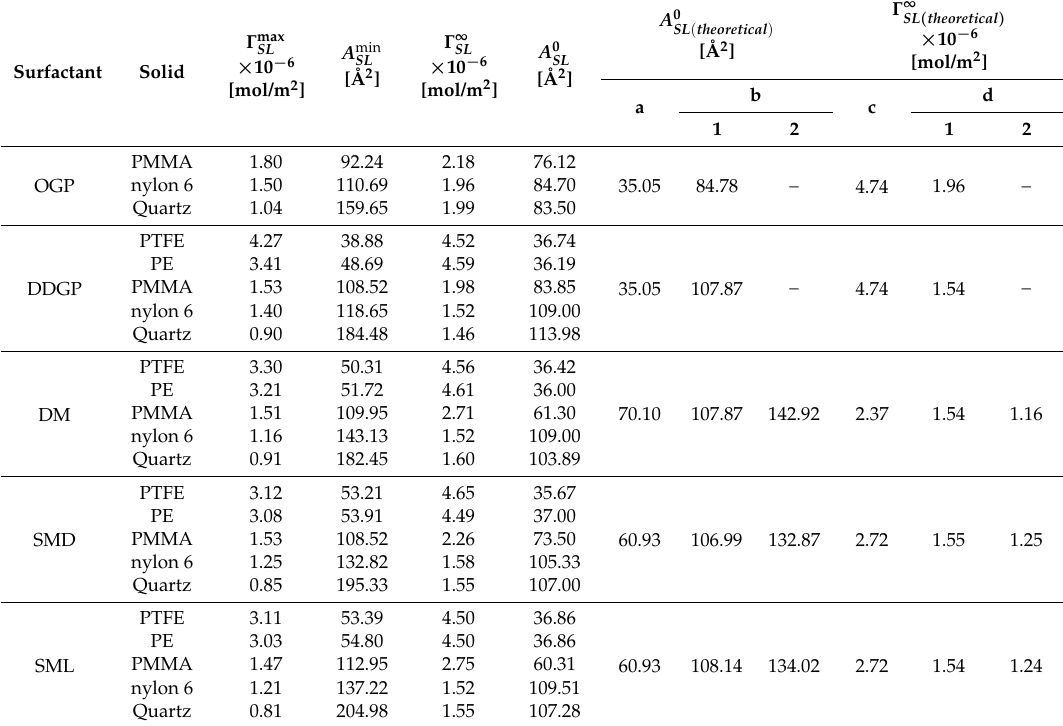
Table 3. The values of maximal Gibbs surface excess concentration ( Γ max maximal possible Gibbs surface excess concentration ( Γ ( A 0 ) and theoretical Gibbs surface excess concentration ( Γ SL ( theoretical ) DM, SMD and SML at their perpendicular and parallel (with one or two sugar units of surfactant disaccharide polar part) orientation toward the solid–water